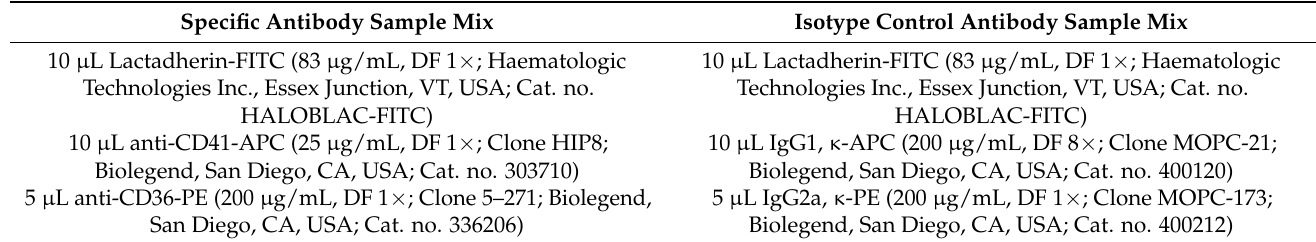
Table 1. Antibody master mix for flow cytometric characterisation of EVs in a single 50 µ L PPP sample. Specific Antibody Sample Mix Isotype Control Antibody Sample